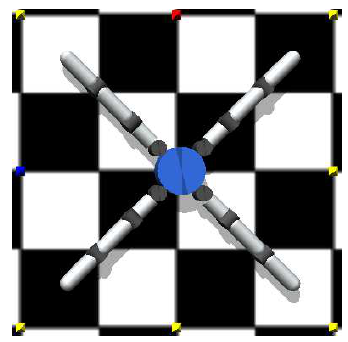
Figure 2. Quadruped robot model used in this study.